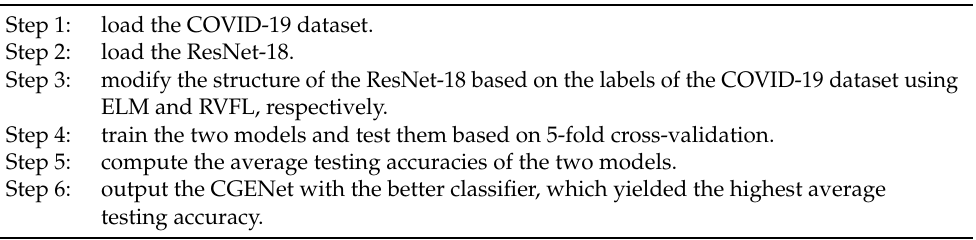
Table 2. Pseudocode of the optimal classifier selection algorithm.